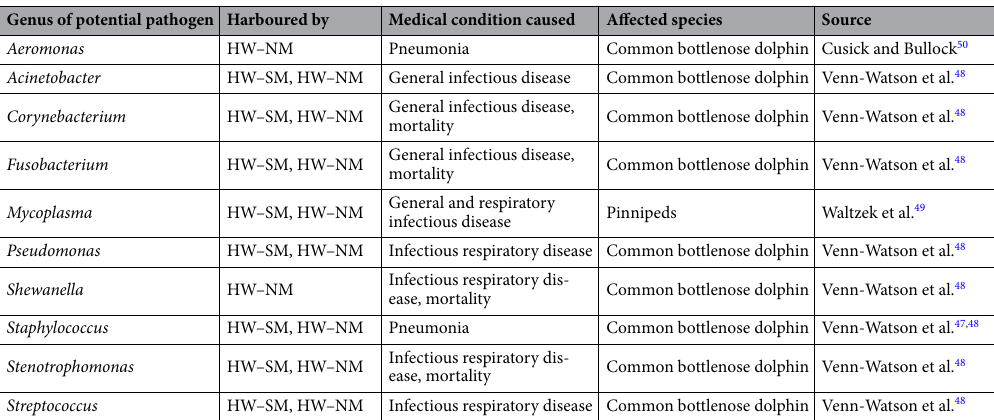
Table 5. Potential marine mammal-specific pathogenic genera found in the blow of both groups of humpback whales [20 humpback whales at the beginning of their fasting (HW–NM) and 20 humpback whales at a later stage (HW–SM)]. The table provides information on the medical conditions and affected species reported in the literature.